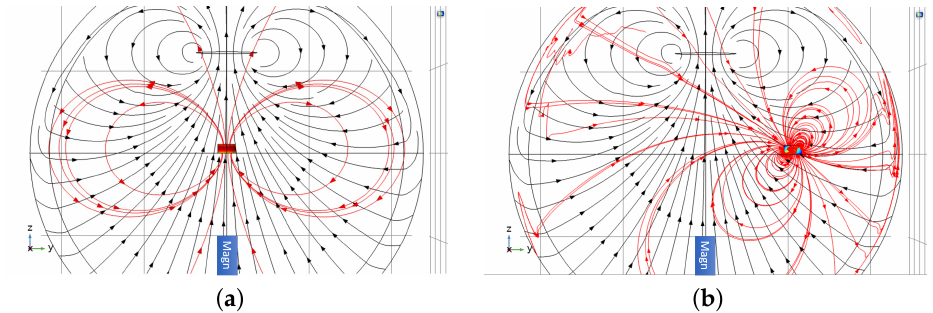
Figure 4. Simulation model results when a solid metallic cylinder is placed ( a ) on-axis and ( b ) off-axis. The magnetic moment of the primary coil (black line) is aligned along the z -axis, and stream plots of the magnetic filed lines (black lines with arrows) produced by the primary coil are shown. The induced secondary magnetic field B ec ( t ) generated by eddy currents in the object are depicted by the red lines and